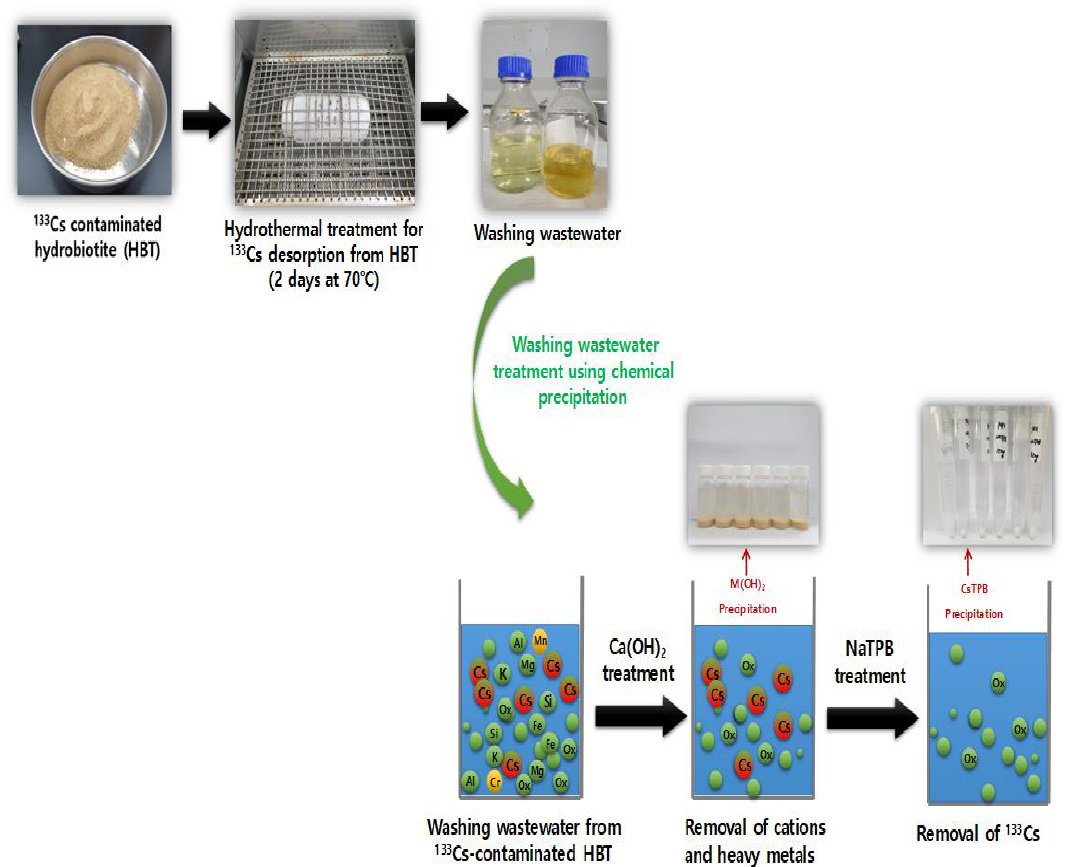
Figure 9. Process flowchart of removing Cs from contaminated 133 Cs–HBT and treating the remaining washing wastewater with chemical precipitation.